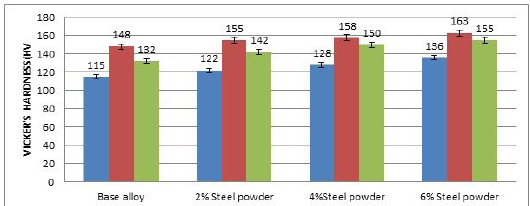
Figure 7. Peak hardness of Al 7075 eutectoid steel composite in hybrid (pearlite) path.